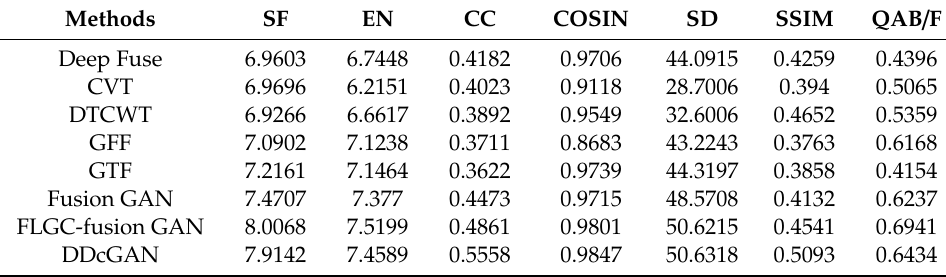
Table 8. Run time comparison of six methods on the TNO datasets. The fusion GAN, FLGC-fusion GAN, and DDcGAN are performed on graphics processing unit (GPU), while others are performed on the central processing unit (CPU). Each value denotes the mean of the run time of a specific method on a dataset (unit: second). Table 7. The average evaluation index value with di ff erent